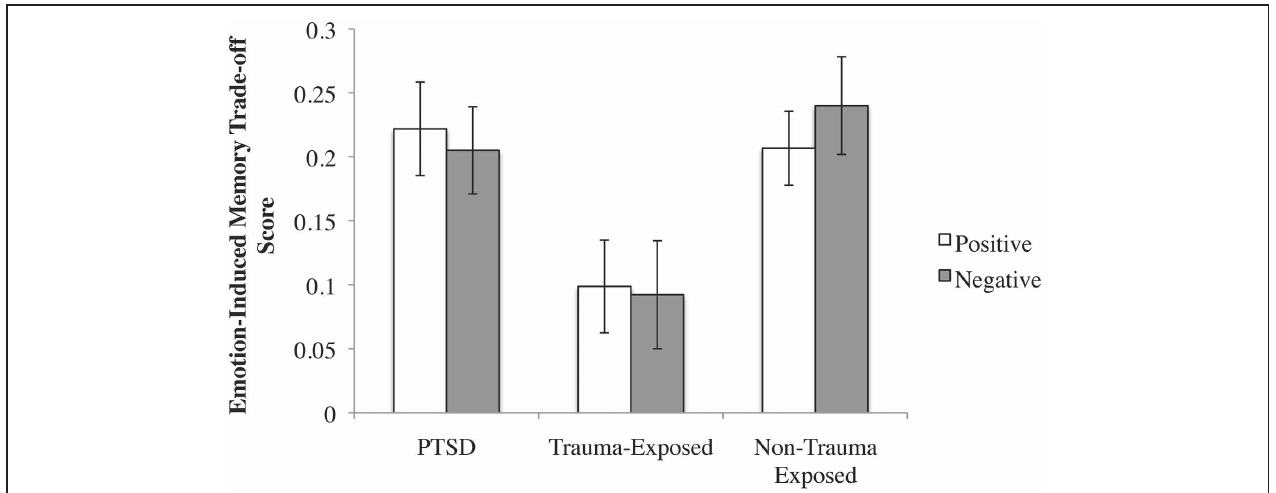
included positive (pleasant) items. Gray bars indicate memory for scenes that included negative (unpleasant) items. There was a larger memory trade-off for both the PTSD and the Non-Trauma Exposed group as compared to the Trauma-Exposed